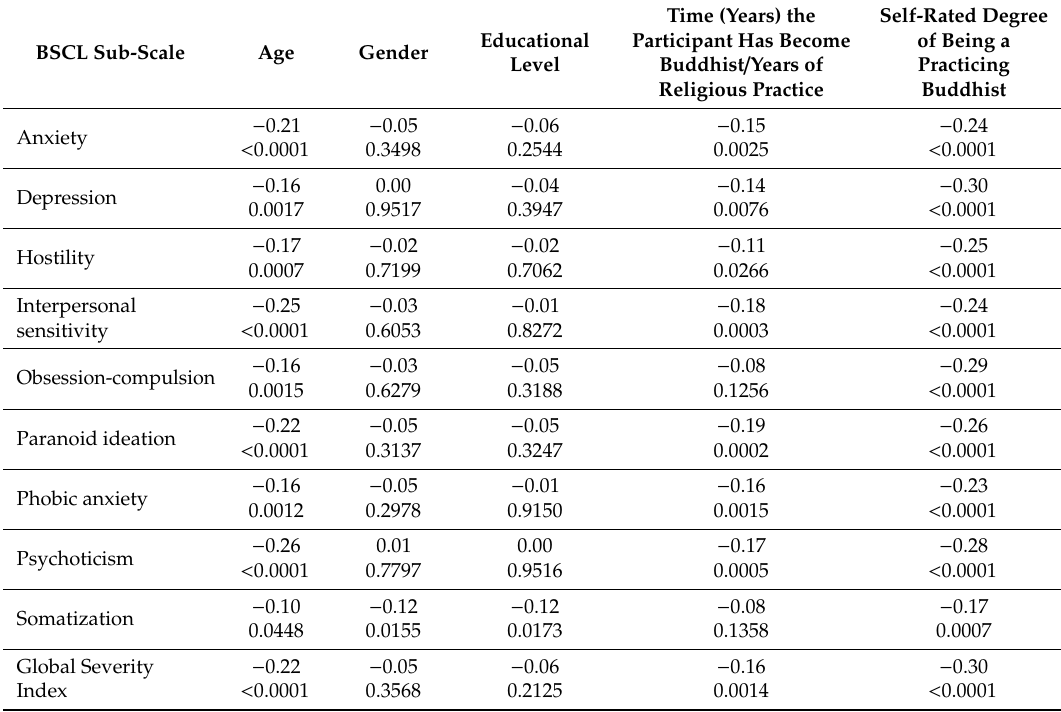
Table 5. Correlations between the Brief Symptom Checklist (BSCL) questionnaire scores, time (years) the participant has become Buddhist and the self-evaluation grade of being a practicing Buddhist. The first value represents the correlation coe ffi cient, the second value the p -value (statistical